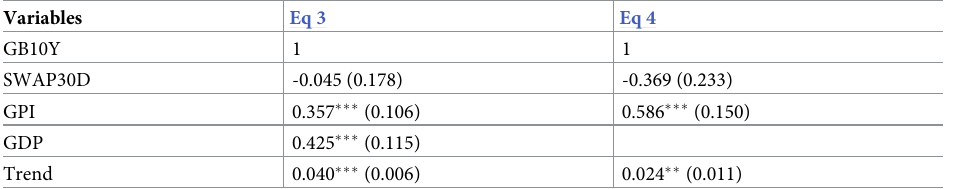
Table 3. Long-run relationship among variables for Eq 3 and Eq 4.